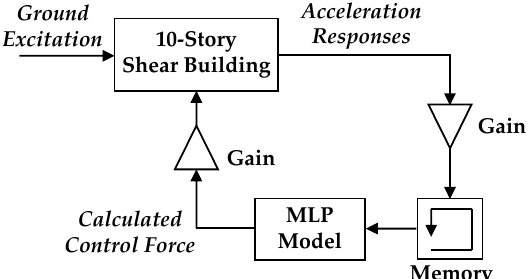
Figure 8. Control simulation model of the MLP (multilayer perceptron).